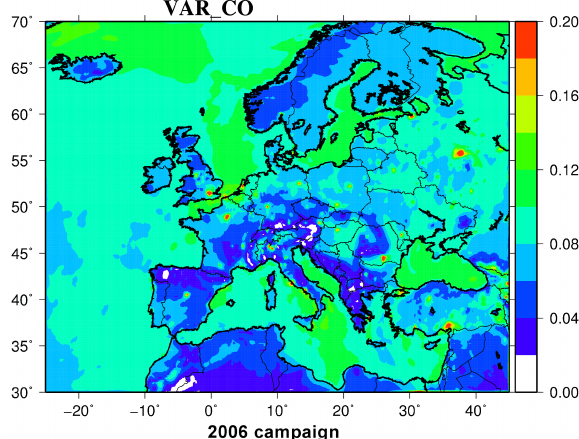
Figure 3. Mean coefficient of variation of the CO concentrations predicted by the models for the 2006 campaign (no unit). Red colour is assigned for values exceeding the colour